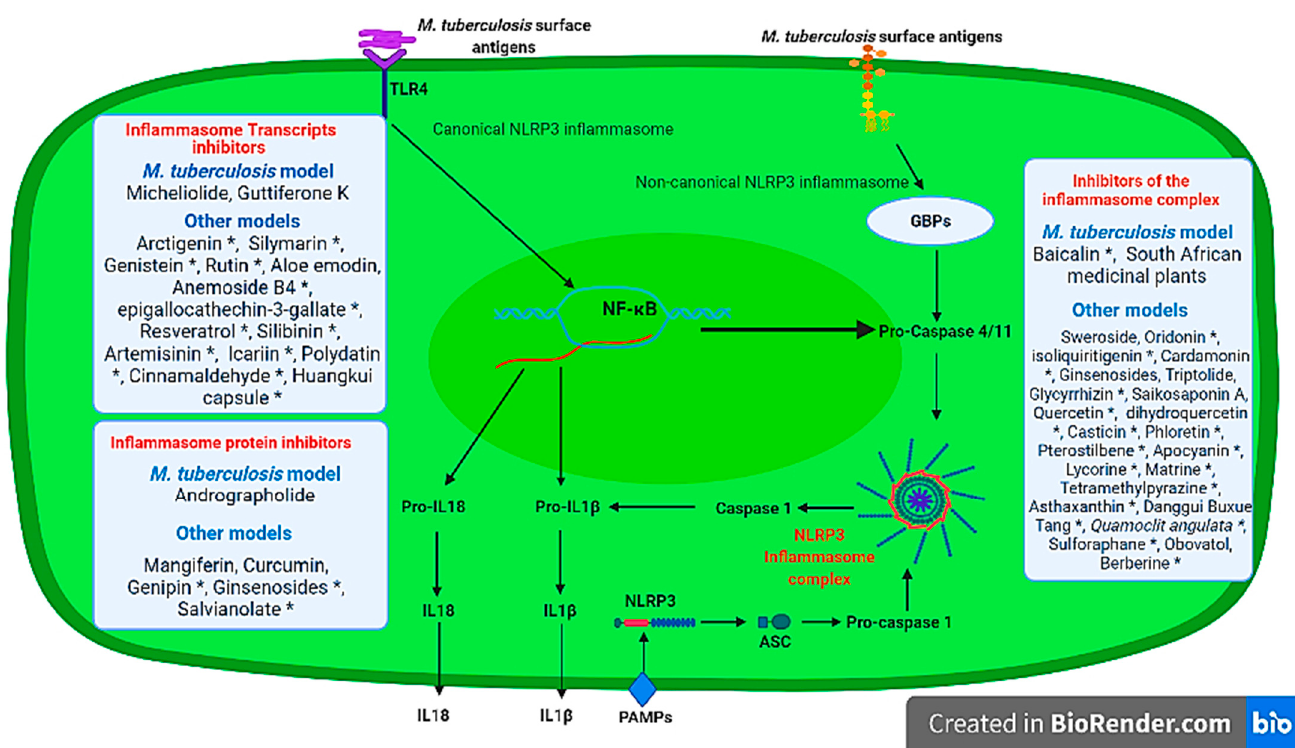
Figure 2. Medicinal plant and/or bioactive regulators of the NLRP3 inflammasome that can be exploited as immunomodulatory host-directed adjuvants during M. tuberculosis infection. Compounds denoted with * were tested in vivo . Image was created in BioRender.com (accessed on 23 August 2021).